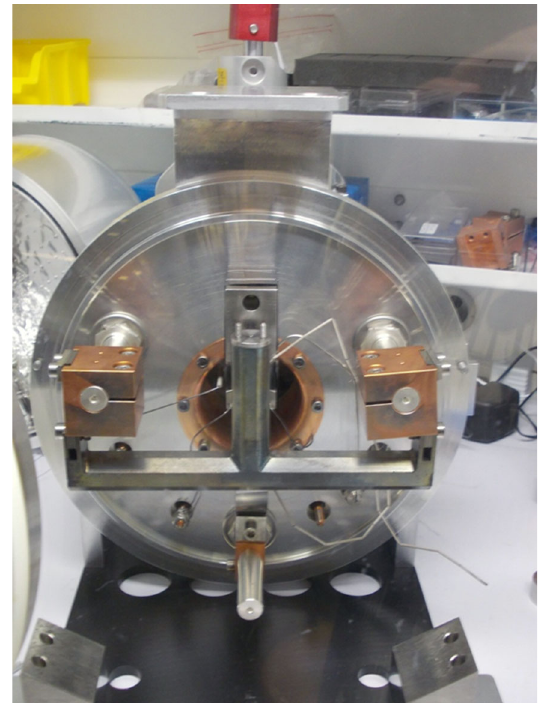
FIG. 6. Picture of the molten salt static target unit used at